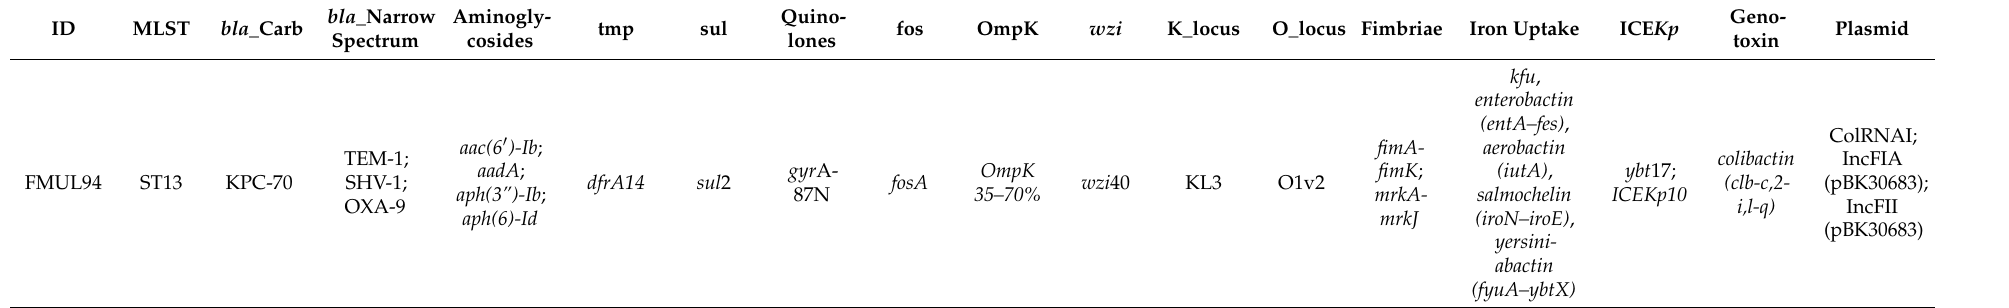
Table 2. Molecular characterization of the ceftazidime/avibactam-resistant K. pneumoniae